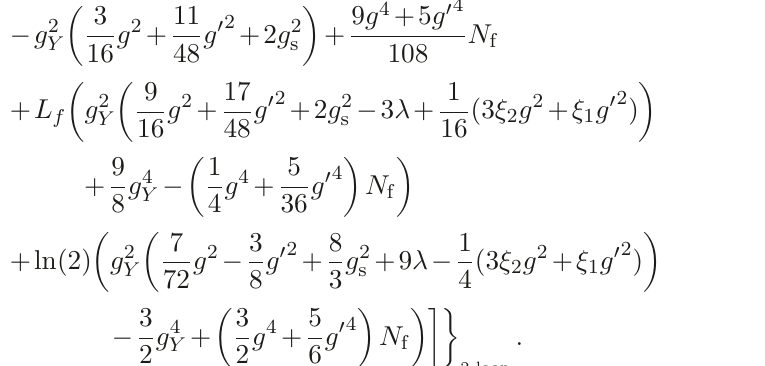
Figure 12 . Diagrams contributing to the Higgs two-point correlator at two-loop level. Scalar fields are represented by arrowed dashed lines, fermions as solid arrowed lines, U(1) gauge fields as wiggly lines, SU(2) gauge fields as zig-zag lines, SU(3) gauge fields as curly lines, and corresponding ghosts as arrowed dotted